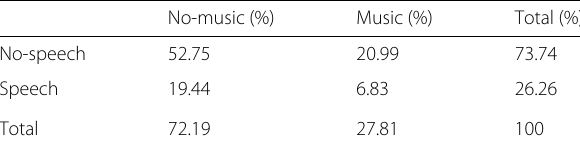
Table 1 Distribution of speech and music events over the 40,906 downloaded balanced train + evaluation